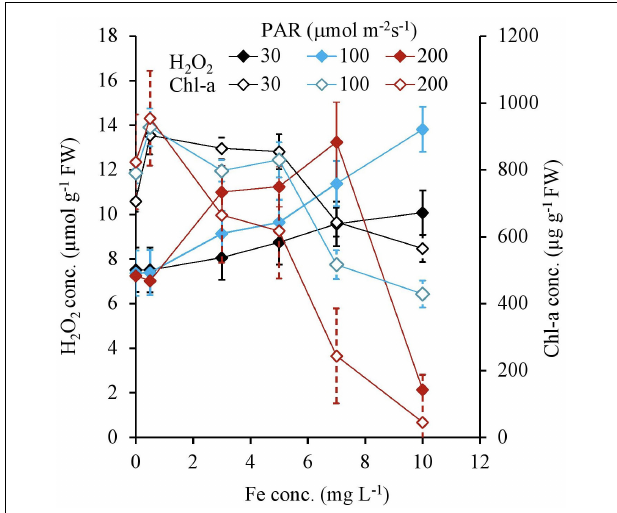
FIGURE 3 | H 2 O 2 and Chl-a concentrations of plant tissues after 7 days of the experiment as a function of Fe concentration in water and PAR intensities.